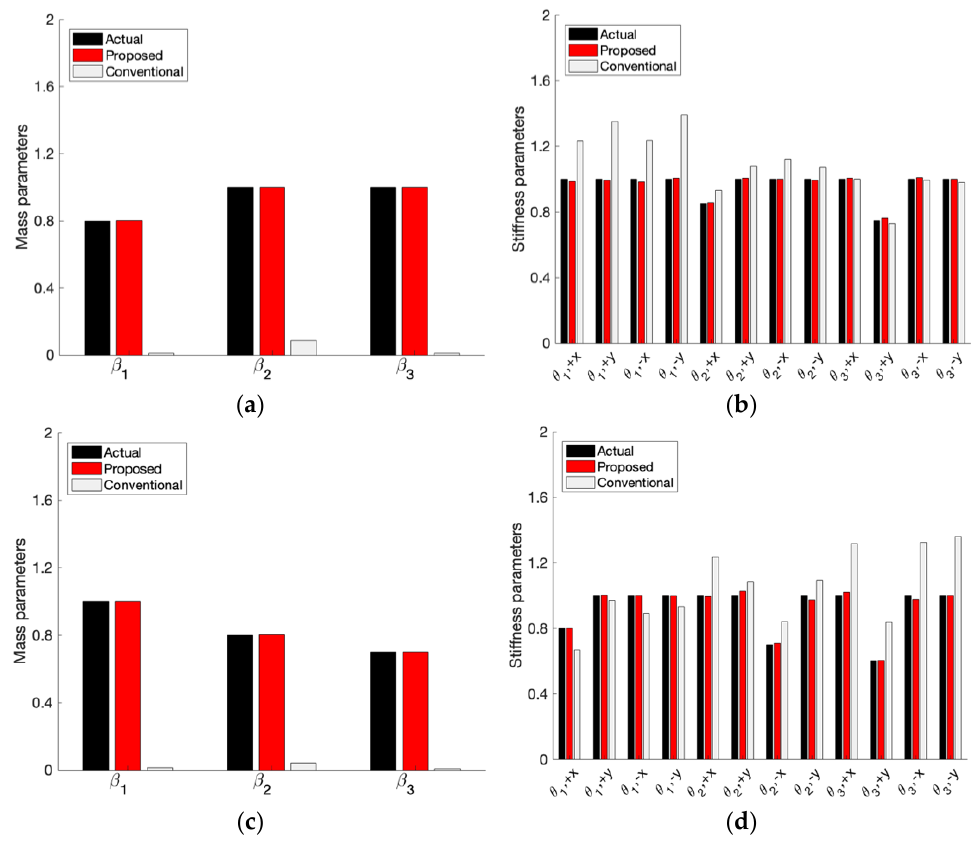
Figure 10. Updated parameters by two approaches. Damage case No. 1: ( a ) mass; ( b ) stiffness. Damage case No. 2: ( c ) mass; ( d ) stiffness.